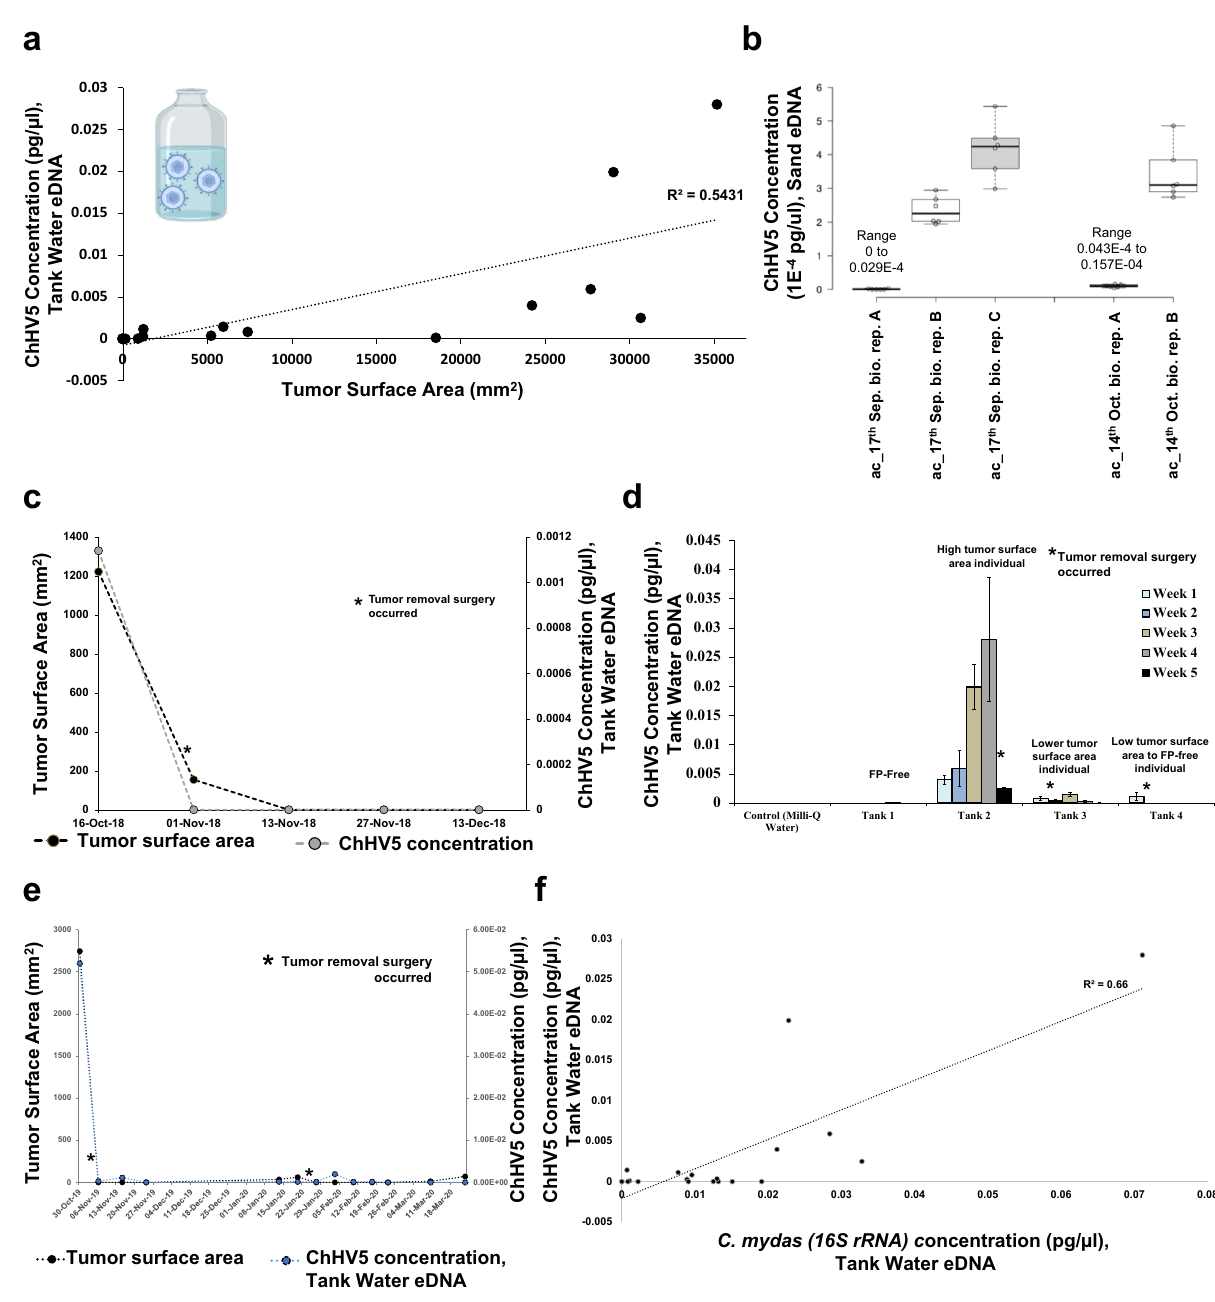
Fig. 2 Environmental DNA (eDNA)-based detection, quanti fi cation, and monitoring of ChHV5 viral shedding into patient tank water, and sand. a Correlation of individual patient tumor surface area (mm 2 ) and the concentration of ChHV5 virus being shed into their tank water, as detected by ChHV5 UL30 gene DNA qPCR (positive correlation, Pearson correlation coef fi cient test, R 2 = 0.5431, p = 0.0002, df = 19). Water containing virus schematic insert was generated using BioRender (https://biorender.com/). b Detection of ChHV5 viral shedding onto sand which a patient ( “ Archie Carr ” 49-2020-Cm) temporarily lay on while awaiting treatment. Detection of ChHV5 UL30 gene DNA by qPCR. Ampli fi cation ratios for each sand sample are provided in Supplementary Table 1. Error bars denote the standard deviation of six technical replicates. c Patient time-course of tumor surface area changes (surgical removal) and concentration of ChHV5 shed into tank water, as detected by UL30 qPCR. d Time-course of ChHV5 viral shedding into four patient tanks, as detected by UL30 qPCR. Tumor removal surgery events are denoted by an asterisk. Note: the ChHV5 eDNA detected in tank 1 in week 4 was due to a second patient (FP-positive) being added to that tank for a single week, due to the rehabilitation needs of the hospital. Error bars denote the standard deviation of three biological samplings, each with three qPCR technical replicates. e Prolonged patient time-course of tumor surface area changes (surgical removal) and concentration of ChHV5 shed into tank water, as detected by UL30 qPCR. f Correlation of Chelonia mydas (green sea turtle) eDNA shedding and ChHV5 eDNA shedding (positive correlation, Pearson correlation coef fi cient test, R 2 = 0.66, p = 0.00001, df = 19), both C. mydas (16S rRNA gene assay) and ChHV5 ( UL30 gene assay) eDNA were detected by qPCR.